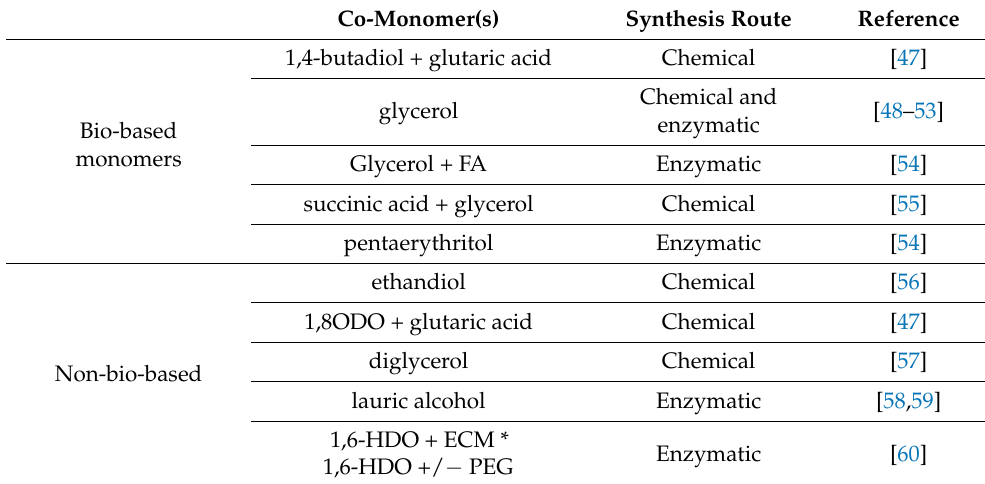
Table 1. Co-monomers used for synthesis of AzA based